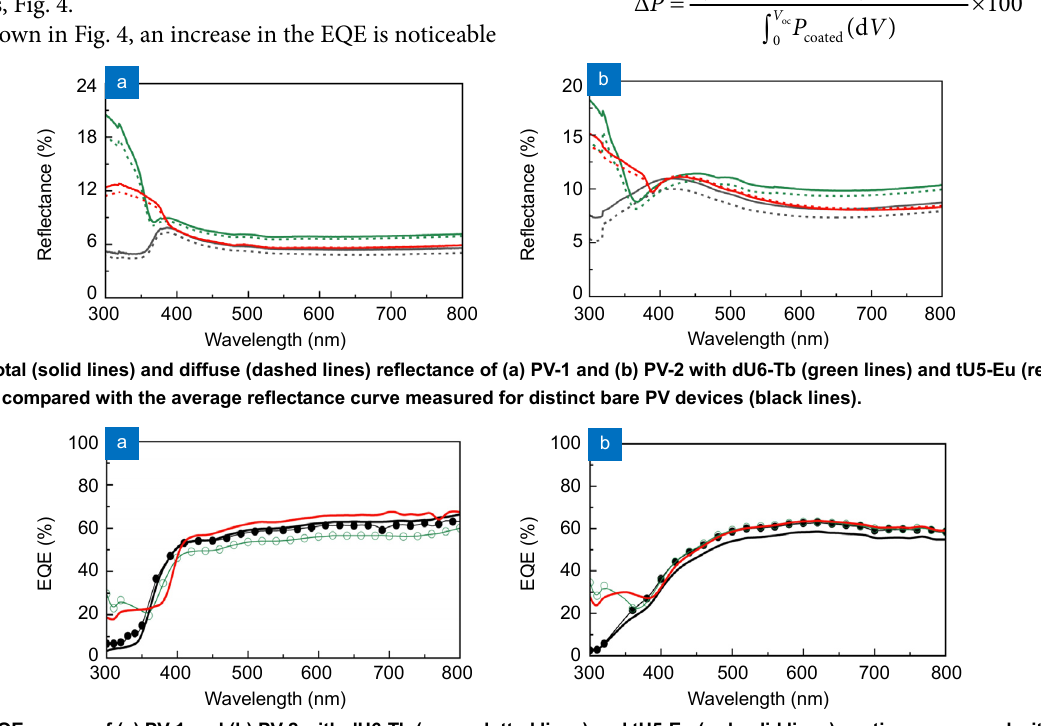
Fig. 4 | EQE curves of (a) PV-1 and (b) PV-2 with dU6-Tb (green dotted lines) and tU5-Eu (red solid lines) coatings compared with the correspondent bare PV devices (black lines).